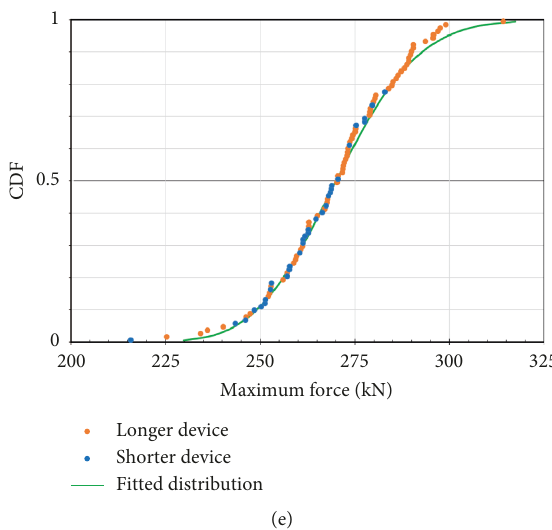
Figure 4: Quasistatic results for the 96 HF2V devices showing statistical distribution of strength. (a) Short stroke devices (tests 1–32). (b) Long stroke devices (tests 33–96). (c) Strength distribution: 32 short stroke devices. (d) Strength distribution: 64 long stroke devices. (e) Strength distribution for all 96 devices. Median strength 270 kN; dispersion of strength (COV) (cid:31) (cid:31)